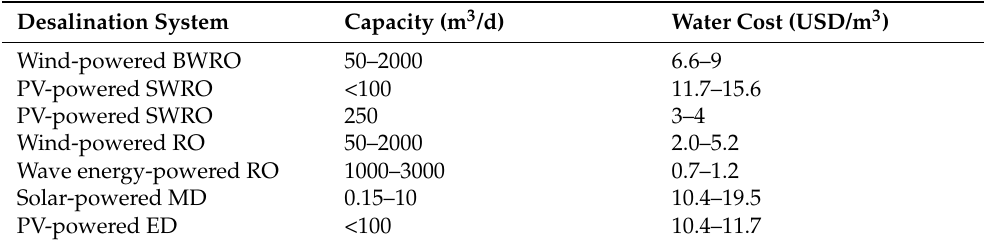
Table 1. Comparison of water production cost in membrane-based desalination processes powered by different renewable energies